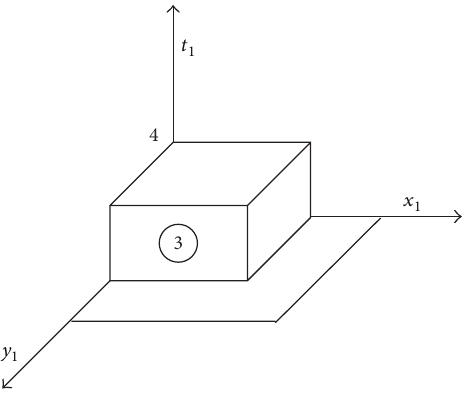
Figure 3: The status of place 1 while activity 3 is put.